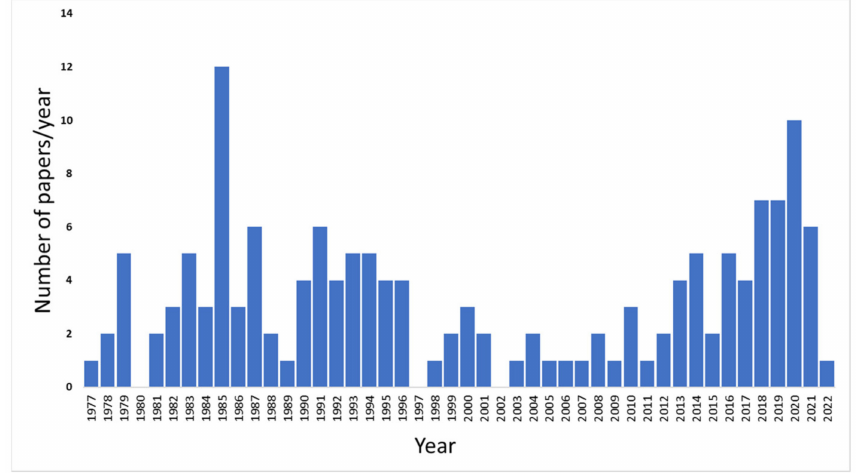
Figure 2. Number of publications per year (from 1977 to 2022) on Gal-3BP and viral infections. The search was performed using PubMed, Scopus, and Google Scholar databases, using the following key words: “(90K OR LGALS3BP) AND